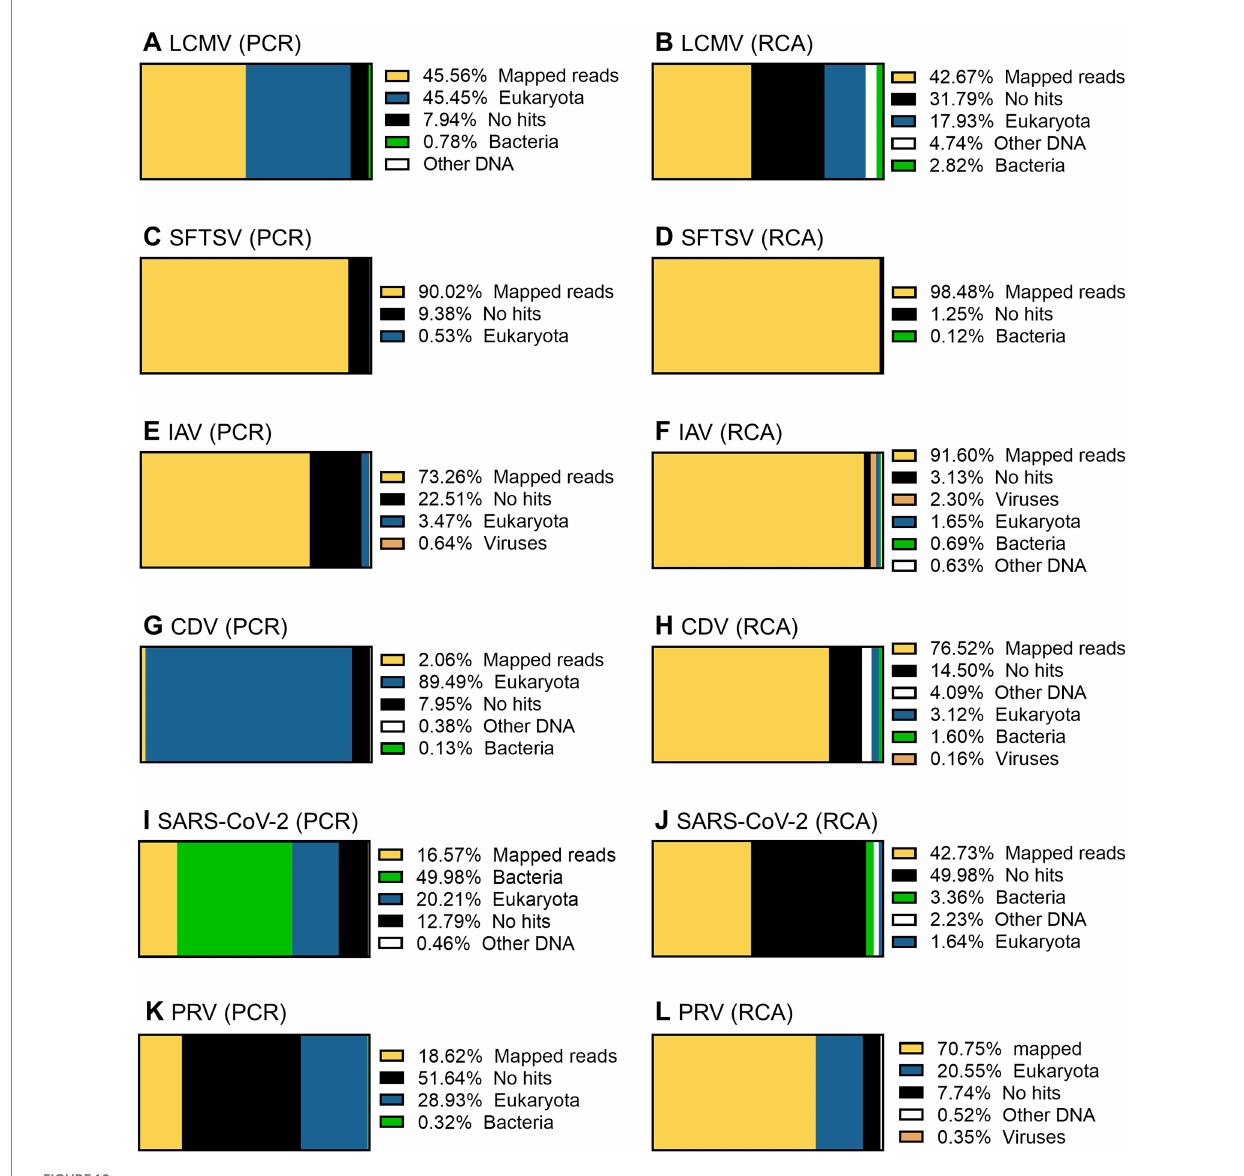
FIGURE 10 Taxonomic profiling of the working stocks of RNA viruses. The total reads obtained by PCR-NGS method (A,C,E,G,I,K) or RCA-NGS method (B,D,F,H,J,L) were firstly reference-mapped to LCMV (A,B) , SFTSV (C,D) , IAV (E,F) , CDV (G,H) , SARS-CoV-2 (I,J) and PRV (K,L) using BWA-MEM sequence aligner. Next, unmapped reads were taxonomically profiled using blastn and Megan. The organism that contains more than 0.1% of the total reads is shown in the figure legend.